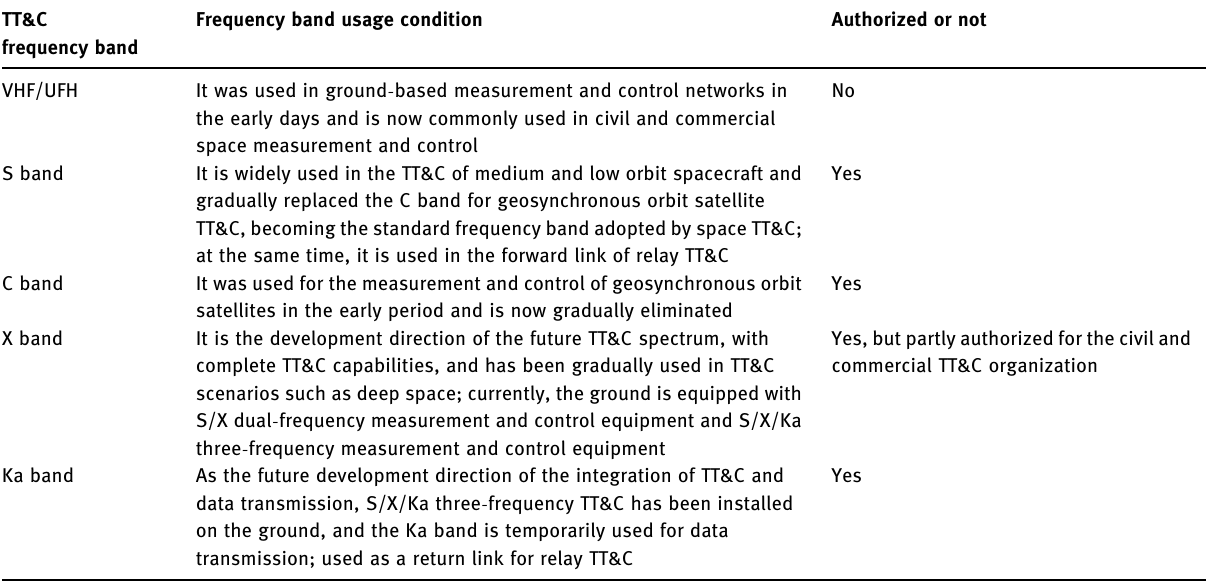
Table 1: Analysis of TT&C spectrum usage of spacecraft in